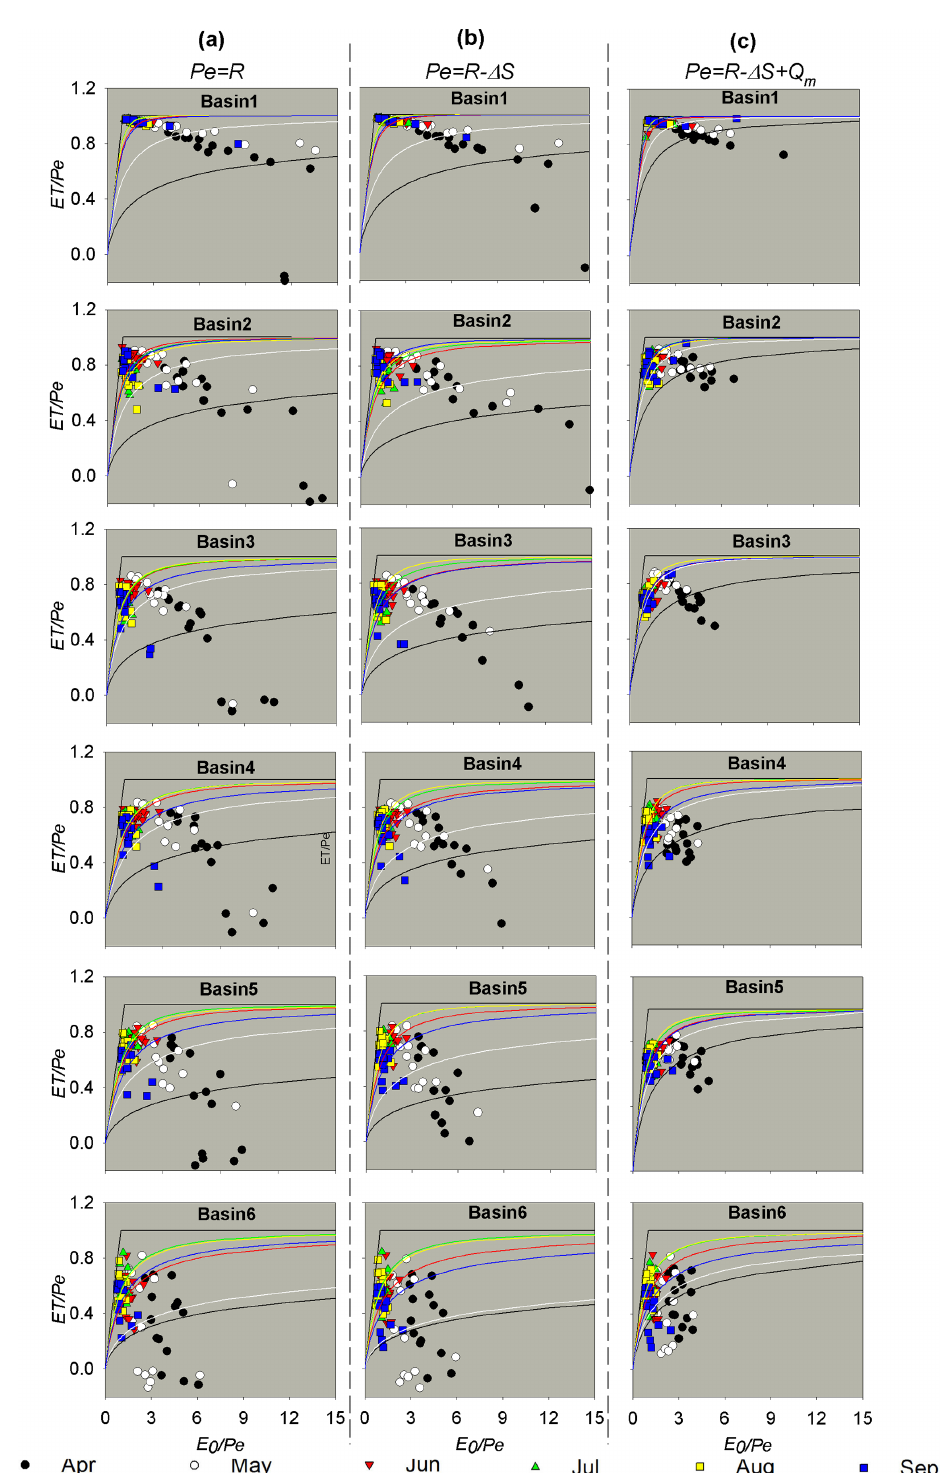
Figure 3. Plots for the aridity index vs. evapotranspiration index scaled by the available water supply for monthly series in the growing season. The total water availability is (a) R , (b) R − (cid:49)S , and (c) R + Q m − (cid:49)S . The n value for each Budyko curve is fitted by long-term averaged monthly